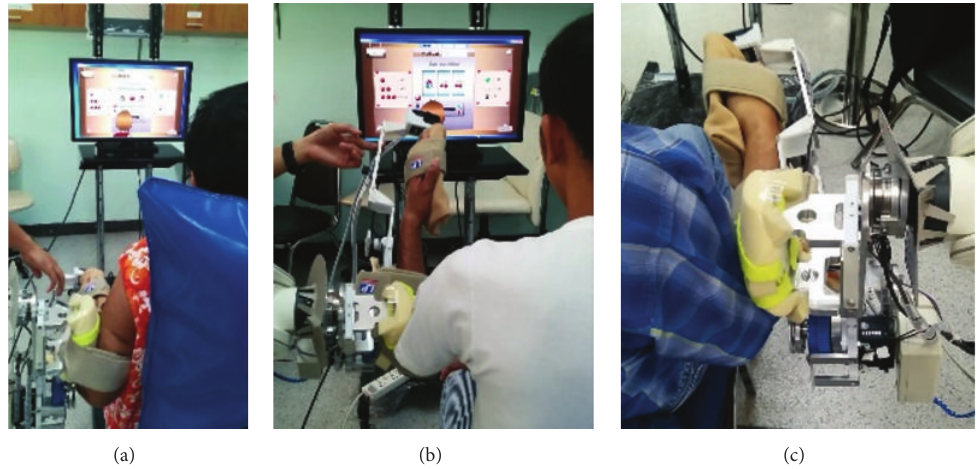
Figure 13: Examples of SEFRE clinical